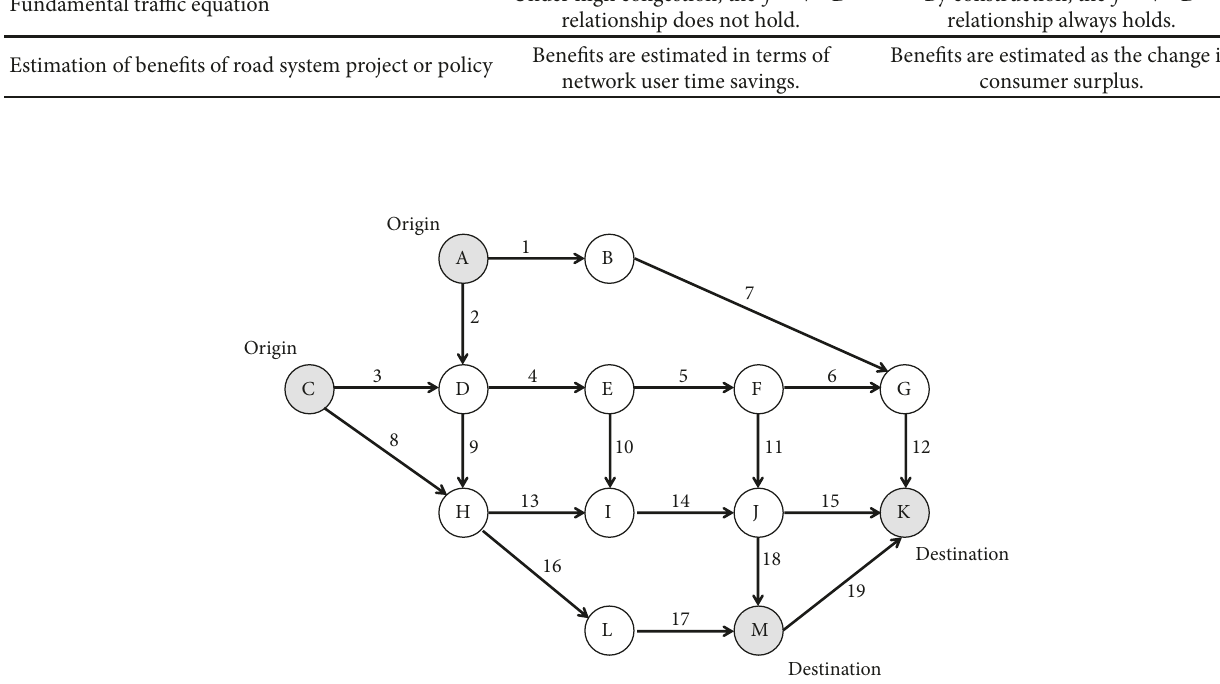
Figure 4: Nguyen-Dupuis Network